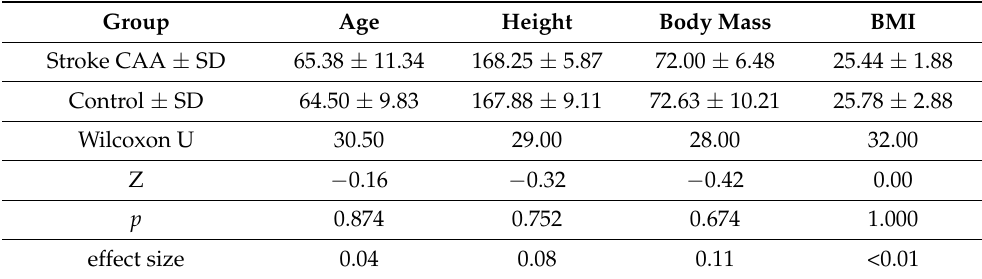
Table 2. Biometric data of CAA population and healthy control